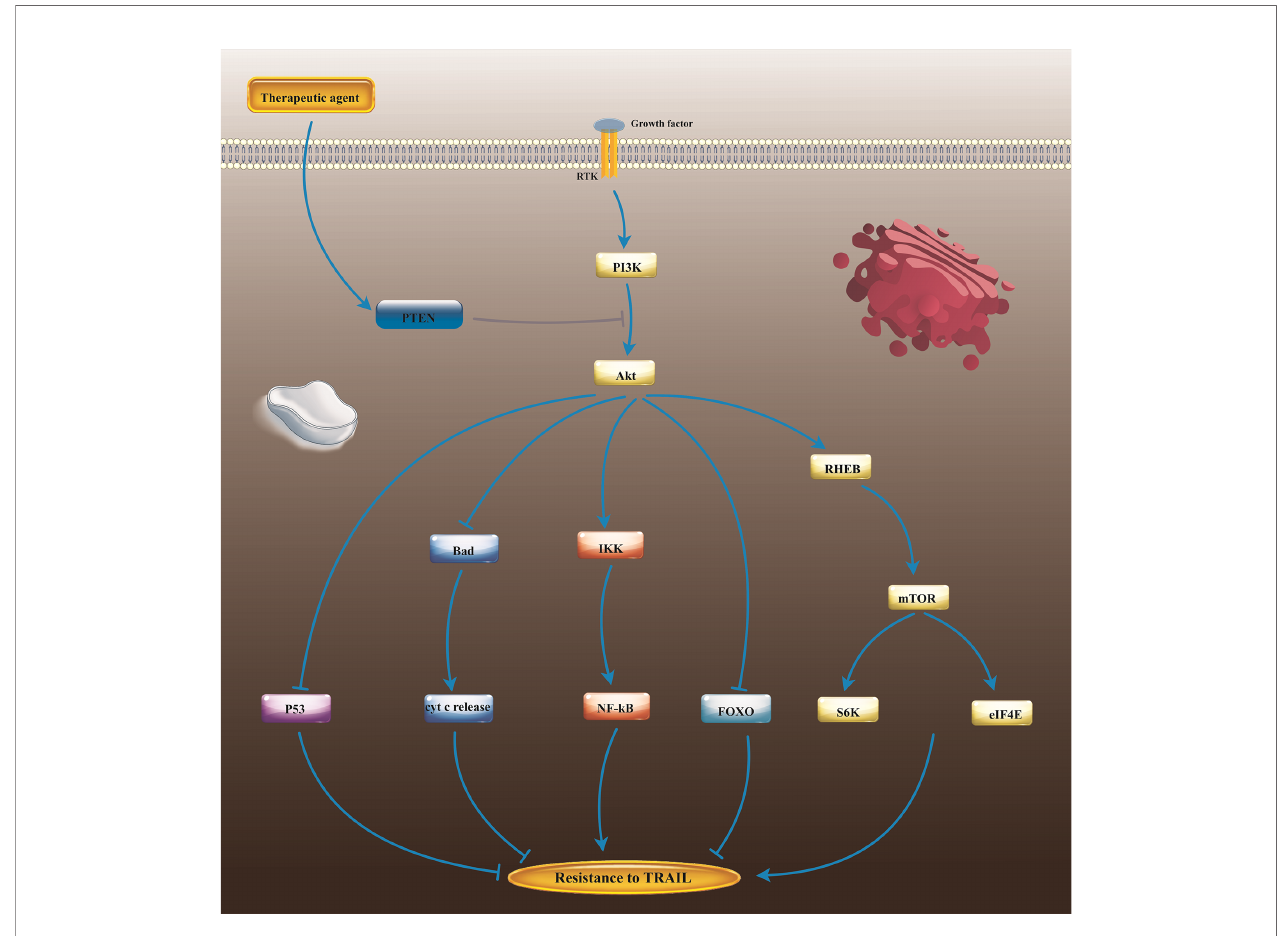
FIGURE 4 | The PTEN important roles in the regulation of cell response to TRAIL. Downregulation of PTEN results in unregulated activation of the PI3K/Akt pathway, which in turn, leads to the tumor cell ’ s resistance to TRAIL. Nonetheless, PTEN up-regulating using therapeutic agents plus TRAIL may support TRAIL- induced apoptosis in TRAIL-resistant cells. TTRAIL, umor necrosis factor-related apoptosis-inducing ligand; PTEN, Phosphatase and tensin homolog; NF -kB, Nuclear actor-kappa B; mTOR, Mechanistic target of rapamycin; PI3K/AKT, Phosphatidylinositol 3-kinase; IKK, IkB kinase; FOXO, forkhead box transcription factors; Bad, Bcl2 associated agonist of cell death; RHEB, Ras homolog enriched in brain; S6K, S6 kinase; eIF4E, Eukaryotic translation initiation factor